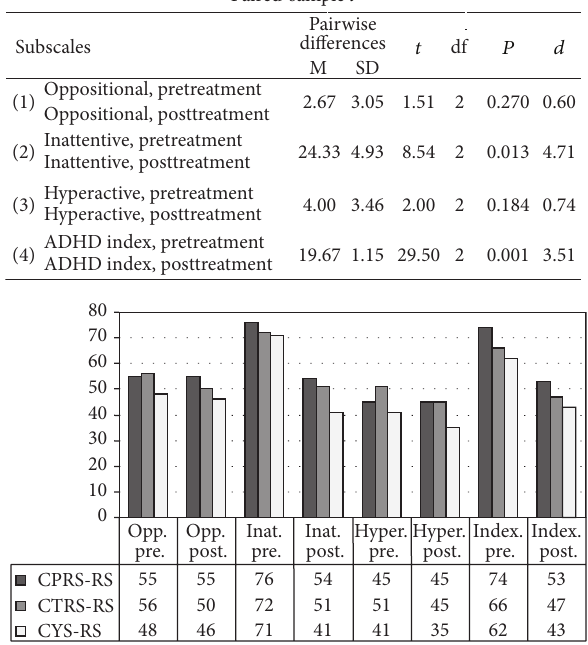
males with XXY is frequent, and it may be strongly